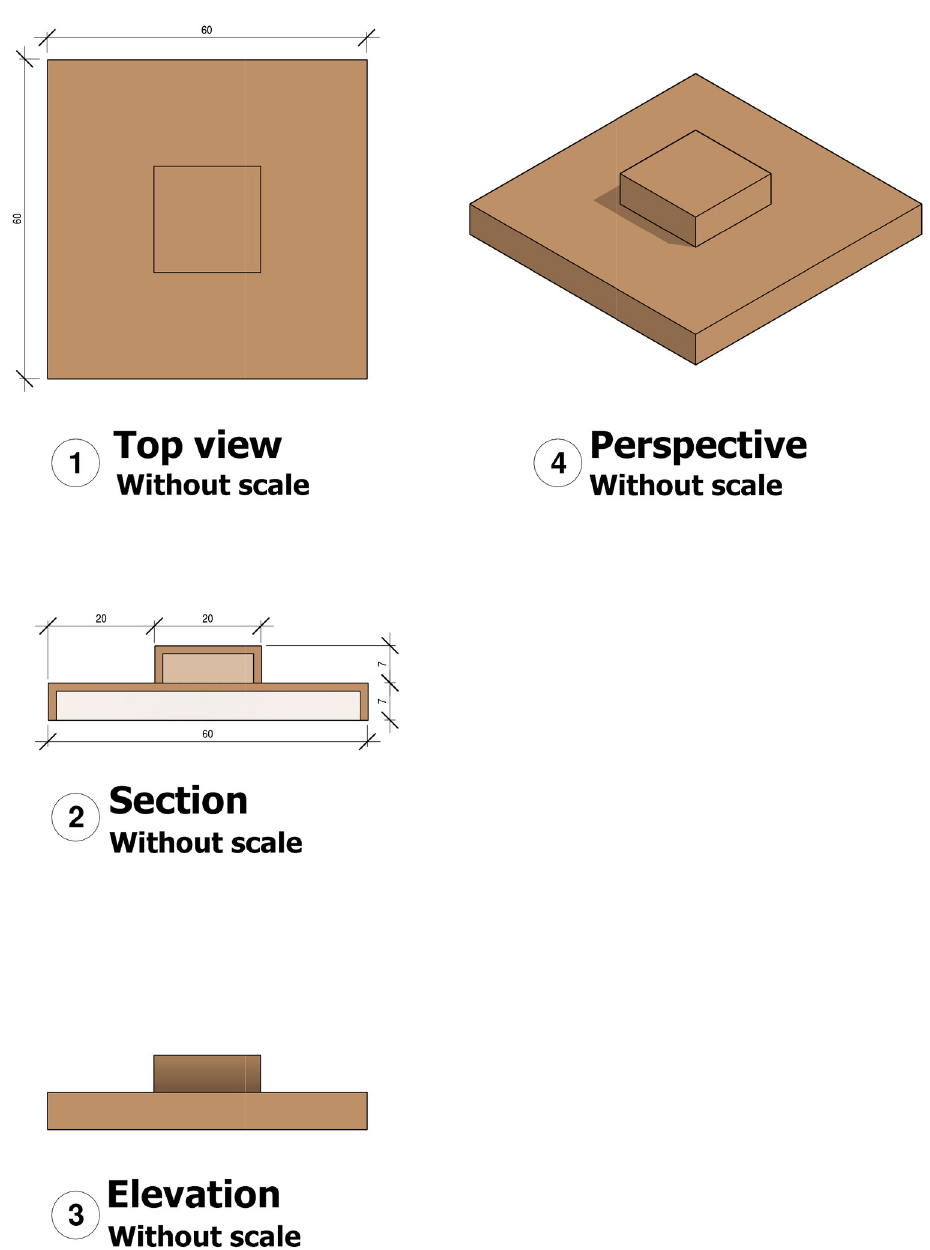
Fig 2. Step platform. (1): Top view with dimensions of the lower base, (2): Section with dimensions of the upper base and of the steps, (3): Elevation, (4) Perspective. individually assessed by the observer, and the frequency at which the behaviour was performed during the observation period was quantified.